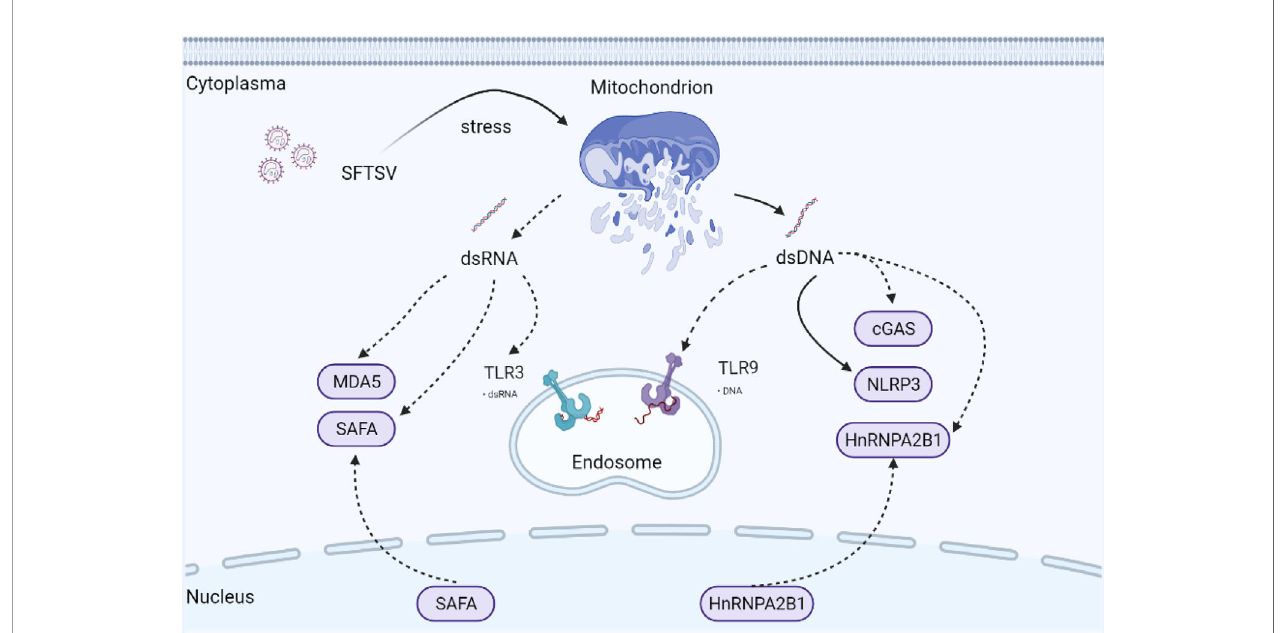
FIGURE 3 | Possible underlying interaction of mitochondria and PRRs under SFTSV infection. Mitochondria are ubiquitous cellular organelles, orchestrating multiple biological processes. Under mitochondrion stress status, BAX/BAK axis is activated mediating mitochondrial permeabilization. mtdsDNA and mtdsRNA are then released into the cytoplasm, which triggers the activation of cytosolic PRRs mediated innate immune response. Solid arrows indicate con fi rmed mechanisms under SFTSV infection. Dotted arrows indicate uncon fi rmed or proposed mechanisms under SFTSV